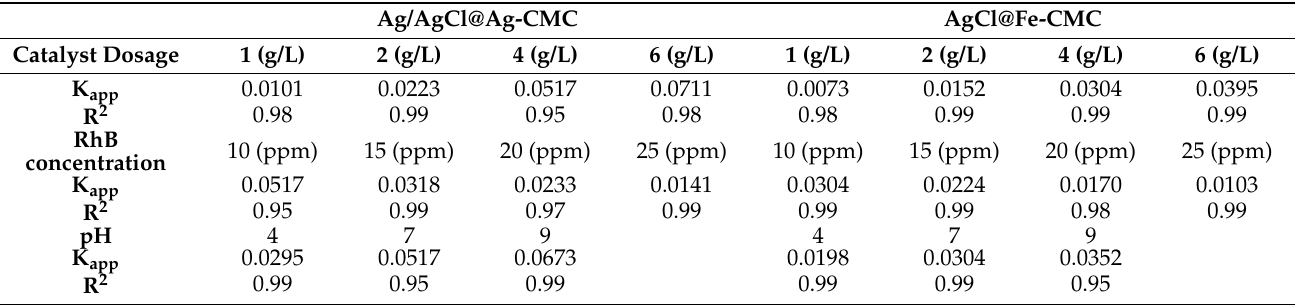
Table 2. Photocatalytic rate constants of Ag/AgCl@Al-CMC and Ag/AgCl@Fe-CMC under different conditions ((copied from Reference